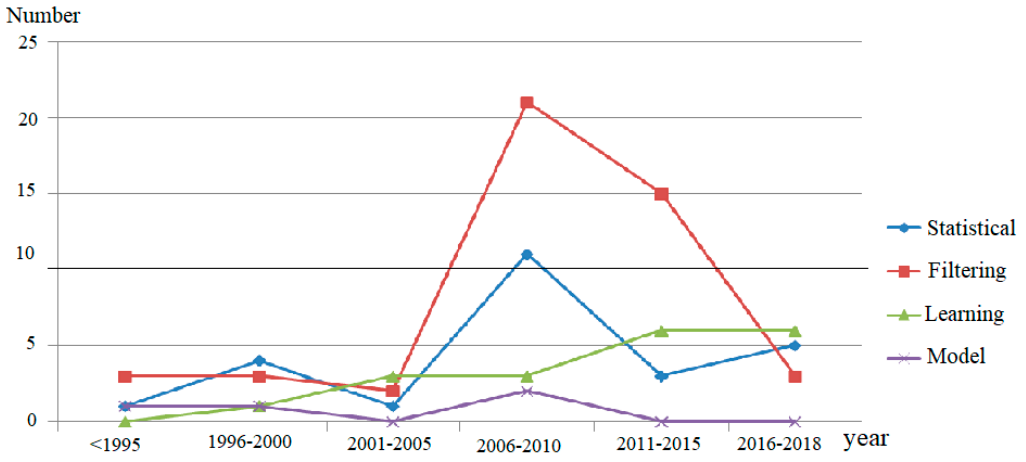
Figure 9. Distribution map detection method.